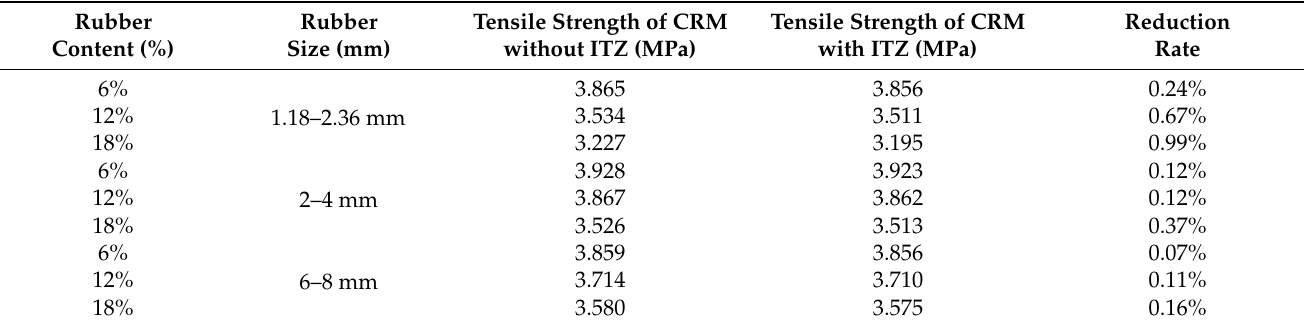
Table 5. Variation in tensile strength of CRM after ITZ is